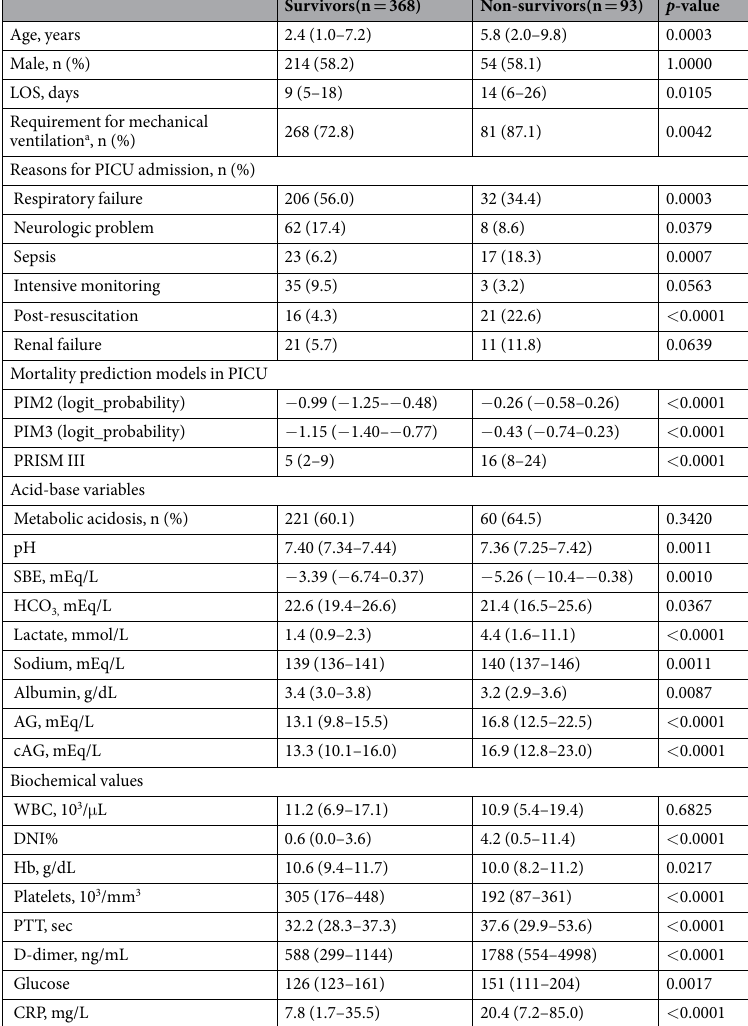
Table 2. Comparison between survivors and non-survivors. Data are presented as number of patients (%) or median value (inter-quartile range). LOS, length of stay; PICU, pediatric intensive care unit; PIM, Pediatric Index of Mortality; PRISM III, Pediatric Risk of Mortality III; SBE, standard base excess; AG, anion gap; cAG, corrected anion gap; WBC, white blood cell count; DNI, delta neutrophil index; Hb, hemoglobin; PTT, partial thrombin time; CRP, C-reactive protein. a Requirement for mechanical ventilation within 24 hours of PICU admission.